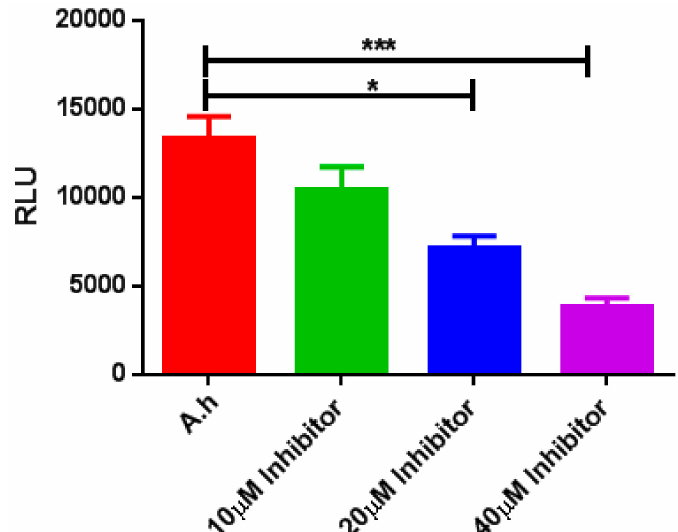
Figure 7. Detection of AI-2 activity via bioluminescence assay of V. harveyi BB170 incubated with culture supernatant of A. hydrophila in the absence (control) and presence of the inhibitor ( − )-Dimethyl 2,3- O -isopropylidene- L -tartrate. The bioluminescence measurement was performed seven hours after